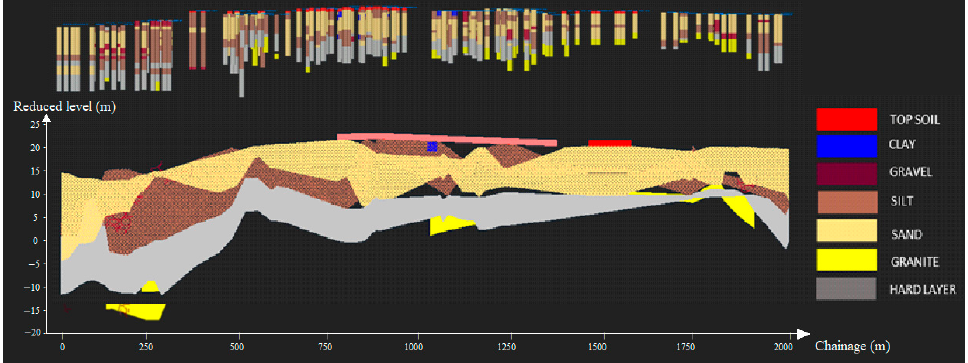
Figure 6. Cross-sectional profile for Case Study 1 based on generalized soil profile.